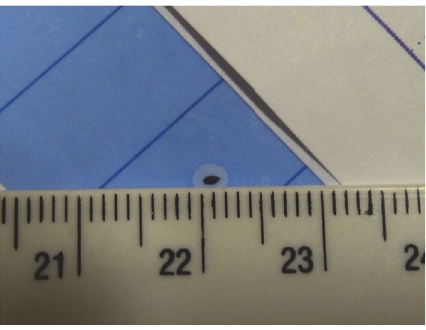
Figure 1: Small metallic IOFB.